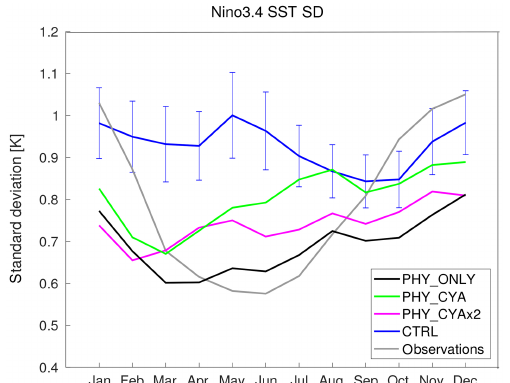
Figure 12. Seasonal cycle of the standard deviations of the Niño3.4 SST index (SST anomalies averaged over the area 5 ◦ S–5 ◦ N, 170–120 ◦ W) for the experiments PHY_ONLY (black), PHY_CYA (green), PHY_CYAx2 (purple), CTRL (blue), and observations (HadISST1; grey). The blue error bars on the blue curve show ± the standard deviation of eight 100-year periods of